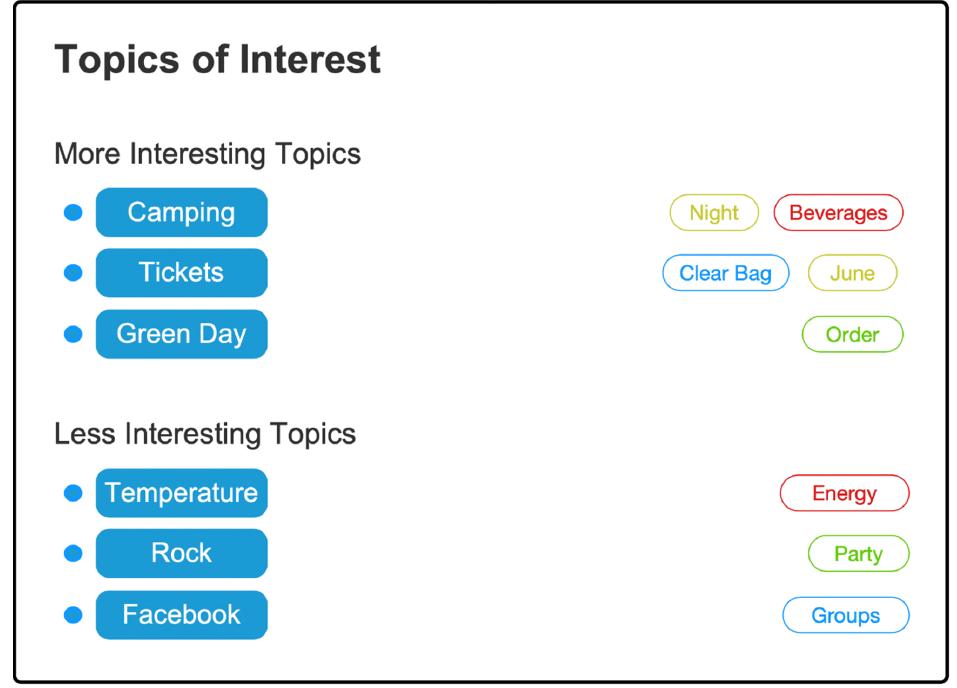
Figure 1. Topics presented to the designer participants. The main topics are on the left and related keywords are on the right. The keyword colors represent the identified sentiment (green: positive, yellow: neutral, red: negative, blue: no